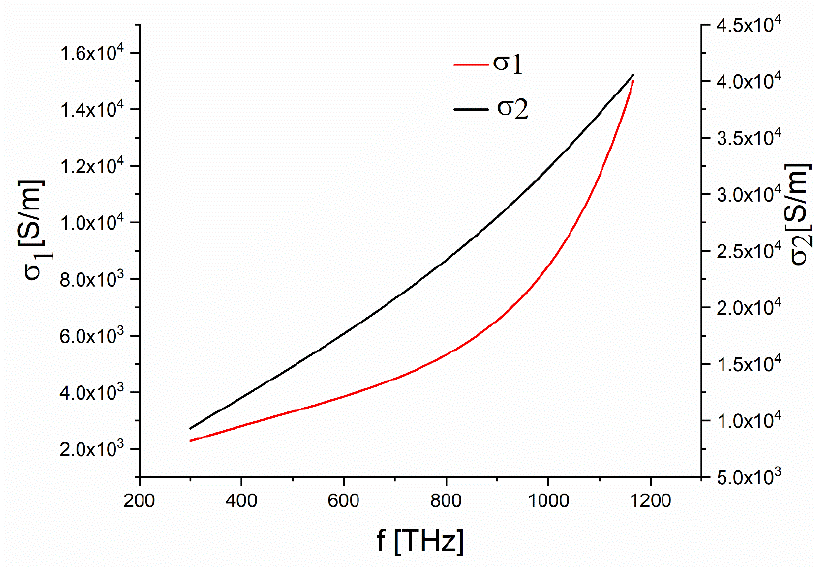
Figure 9. The optical conductivity dependence on frequency of RGO films on glass substrates.